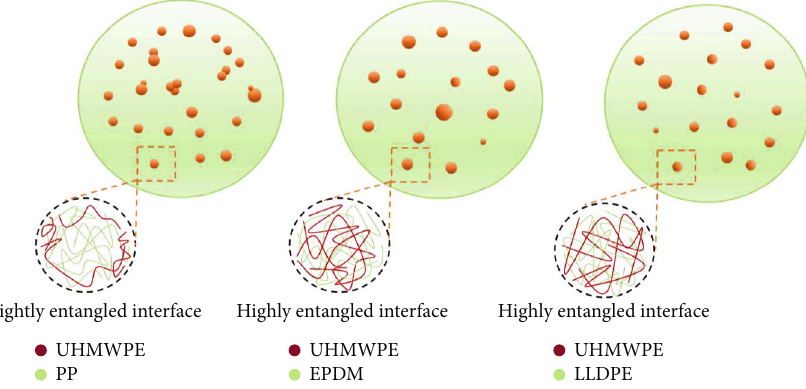
Figure 8: Interfacial interdi ff usion of PP/U, EPDM/U, and LLDPE/U